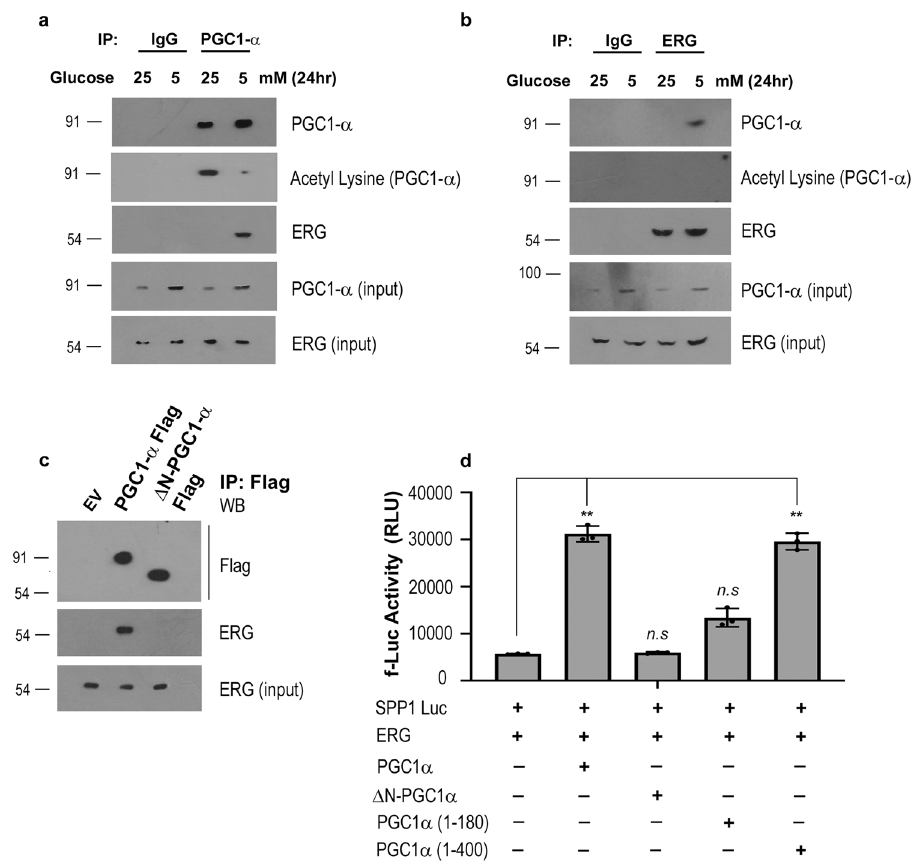
Fig. 2 PGC1 α interacts and transactivates ERG fusion. a VCaP cells were treated as indicated. Cells were harvested after 24 h and subjected to immunoprecipitations using anti-PGC1 α antibody or anti-IgG antibody, and western blots were performed for the indicated proteins. b VCaP cells were treated as indicated. Cells were harvested after 24 h and subjected to immunoprecipitations using anti-ERG antibody or anti-IgG antibody, and western blots were performed for the indicated proteins. c VCaP cells were transfected with either vector control(EV), PGC1 α Flag, or Δ N-PGC1 α Flag as indicated. Cells were harvested 24 h post-transfection and subjected to immunoprecipitations using anti-FLAG antibody and western blots were performed for the indicated proteins. d PC3 cells were cotransfected as indicated. Luciferase assay was performed 24h post-transfection and relative fi re fl y luciferase activity was plotted. Experiments were performed as biological triplicates (mean ± SD). One-way ANOVA with Dunnett ’ s multiple comparison test was used for statistical signi fi cance of 2d where ** p = ERG interacts with a deacetylated form of exogenously expressed PGC1 α (Fig. S2a, b). We found similar endogenous interaction during serum deprivation in VCaP cells between ERG and PGC1 α (Fig. S2c). To understand if the PGC1 α transactivation domain (1 – 180 amino acid) 34 is necessary for interaction with ERG protein, we performed interaction studies using ectopic Δ N-PGC1 α FLAG (PGC1 lacking 1 – 180 amino acid) in VCaP cells. We did not observe any pull-down of ERG protein with Δ N-PGC1 α FLAG (Fig. 2c). Moreover, Δ N-PGC1 α FLAG could not transactivate